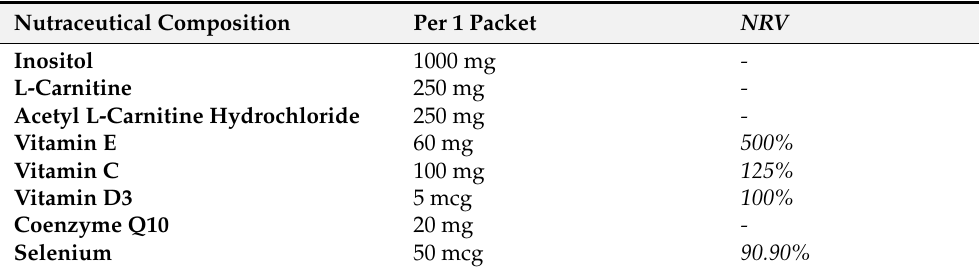
Table 1. Composition, Dosage and Nutrient Reference Values (NRVs) of the administered nutraceuti- cal preparation.